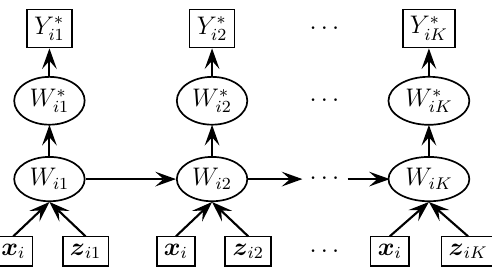
Figure 1. Graphical representation of the proposed model. Square boxes represent observed variables, and ovals represent latent variables. The direction of the arrows indicates conditional